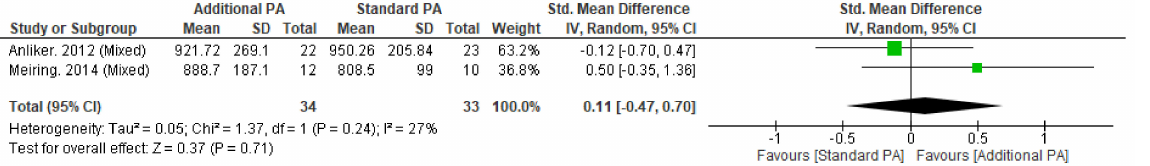
Figure A5. Effect of additional exercise interventions on the polar stress–strain index within the Tibia (38%) at less than 12 months follow-up. Legend: PA = Physical Activity, Std = standardised, IV = inverse variance, SD- standard deviation, CI = confidence